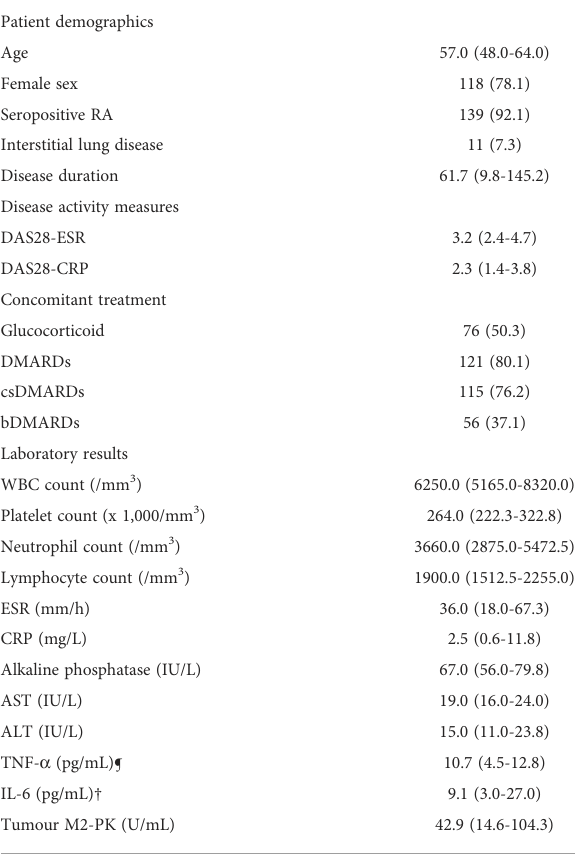
TABLE 1 Baseline characteristics of patients with